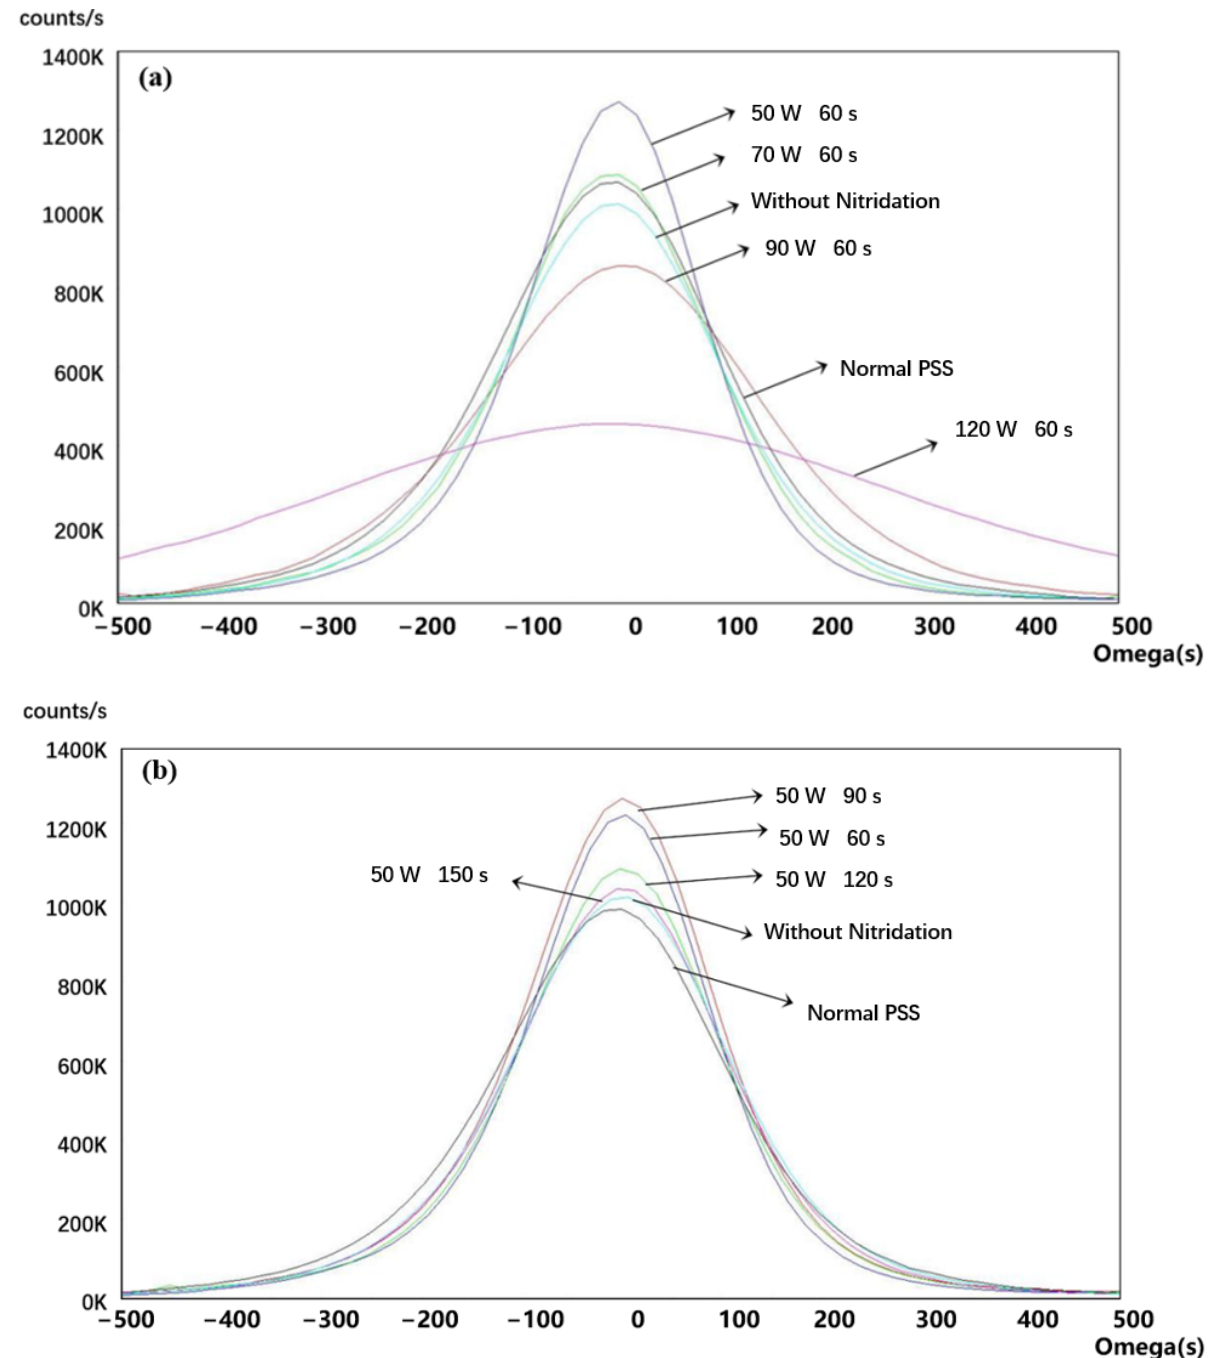
Figure 6. The ω mode scanning of (1102) planes on the samples of the complete LED epitaxial structure. The data were smoothed with the same order. ( a ) Results classified by the AC powers and ( b ) results classified by the nitridation times.